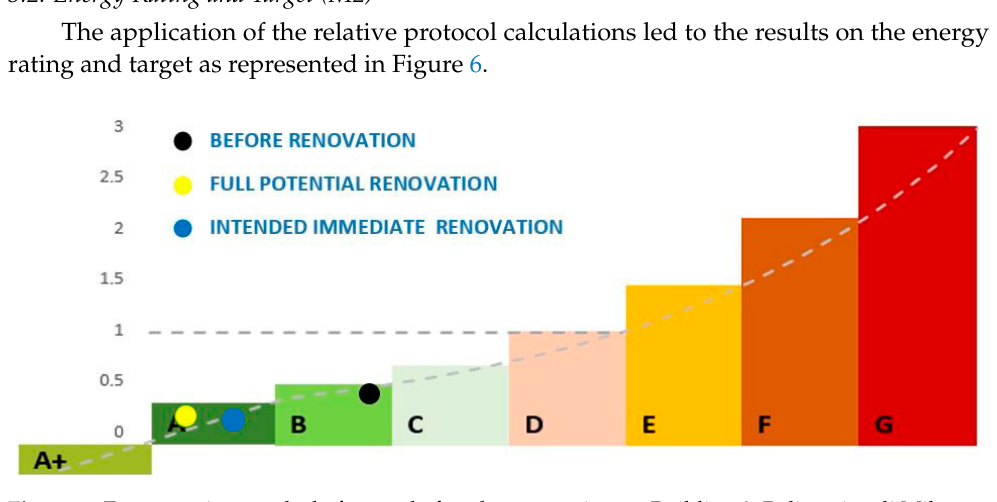
Table 12. ALDREN KPIs results of the Italian case with the RenoMap full packages application. KPI